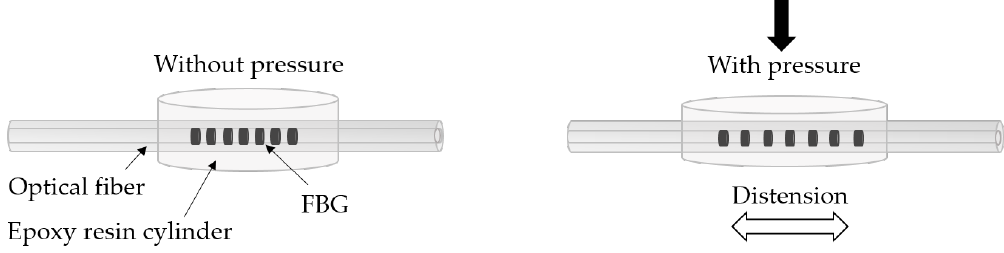
Figure 2. Sensor design and effect of pressure on the sensor.